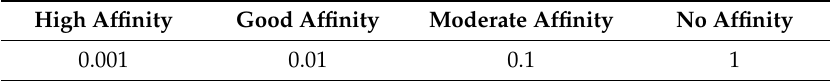
Table 1. The value of viscosity correction factor indicated in Equation (2).